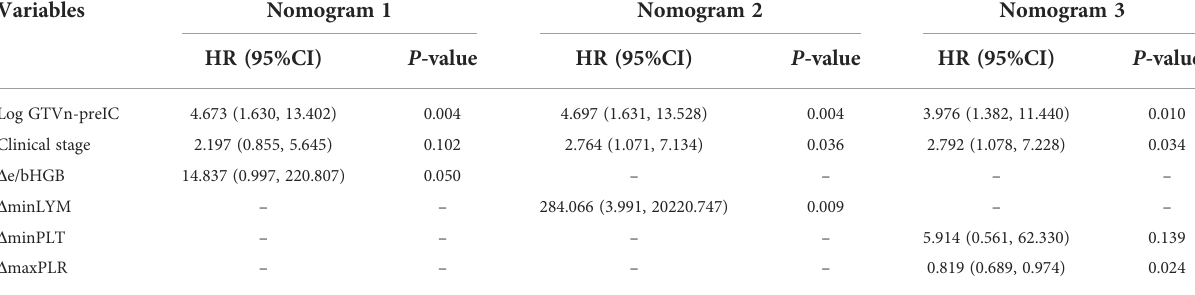
TABLE 2 Multivariate Cox